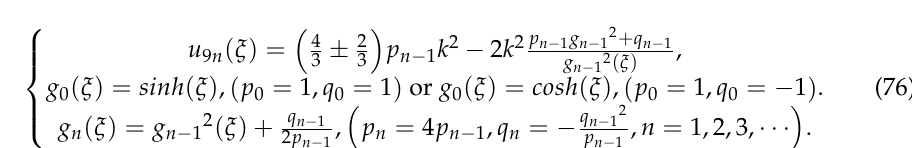
Figure 8. Evolution of solitary waves with n in u 8 n when k = 1: ( a ) n = 1, ( b ) n = 2, ( c ) n = 3, and ( d ) n =